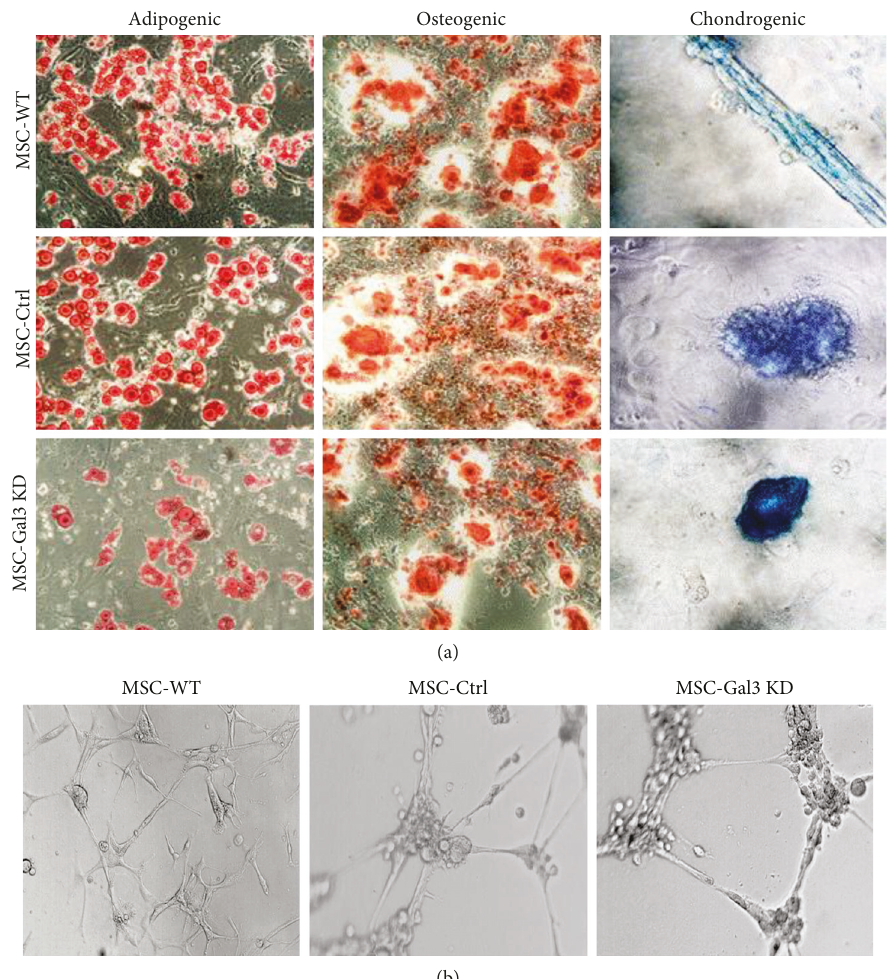
Figure 2: Characterization of MSC lines by di ff erentiation assays. (a) Trilineage di ff erentiation assay performed in MSC lines to generate adipocytes, visualized by Oil red staining, osteocytes, visualized by alizarin red staining, and chondrocytes, visualized by Alcian blue staining, respectively. (b) Angiogenic ability demonstrated by endothelial tube formation assay on Matrigel. MSC-WT =wild-type MSC; MSC-Ctrl=MSC transduced with a nontargeting shRNA vector; MSC-Gal3KD =Gal-3 knockdown MSC. Magni fi cation =200x.